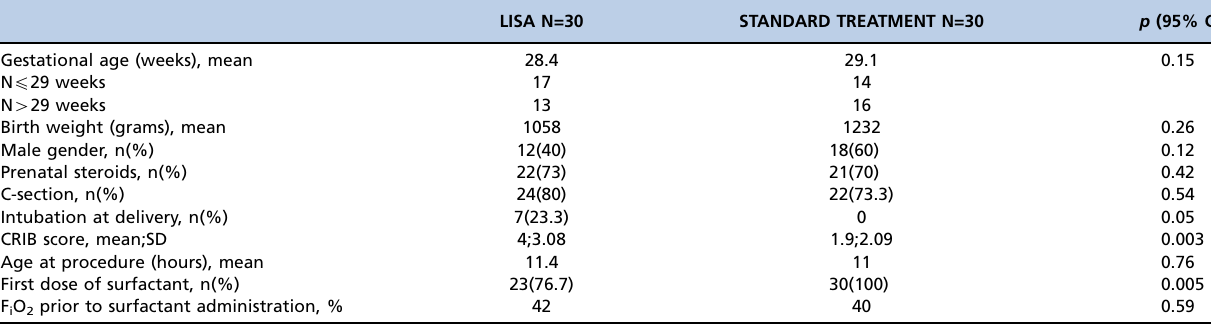
Table 2 - Baseline characteristics of the study